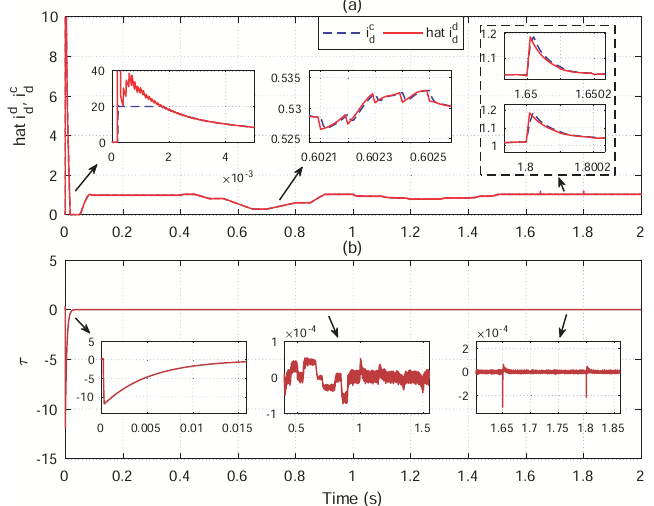
Figure 9. ( a ) Input and output signals of second-order sliding mode differentiator (SOSMD). ( b ) Compensation signal of